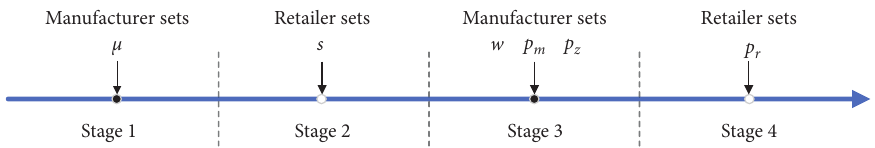
Figure 3: Decision-making sequences in the coordination